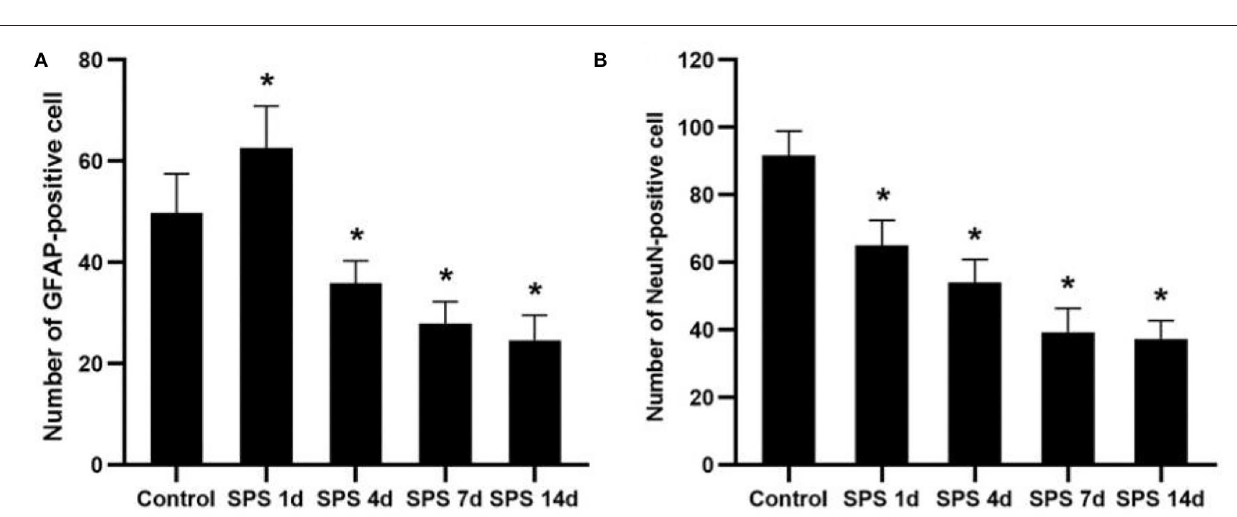
FIGURE 9 | Number of NeuN- and GFAP-positive cells. (A) number of GFAP-positive cells in mPFC of control and SPS groups; (B) number of NeuN-positive cells in mPFC of control and SPS groups. * P < 0.05 vs. control